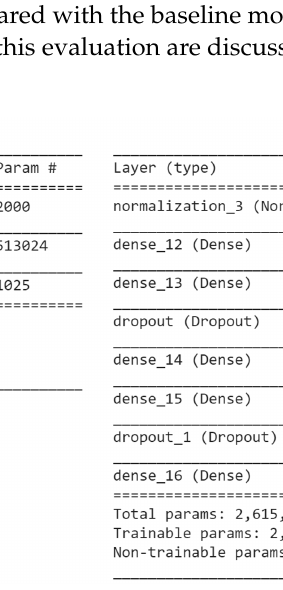
Figure 6. Layout summary of our ANN designs, shallow ANN ( left ), and deep ANN ( right ).